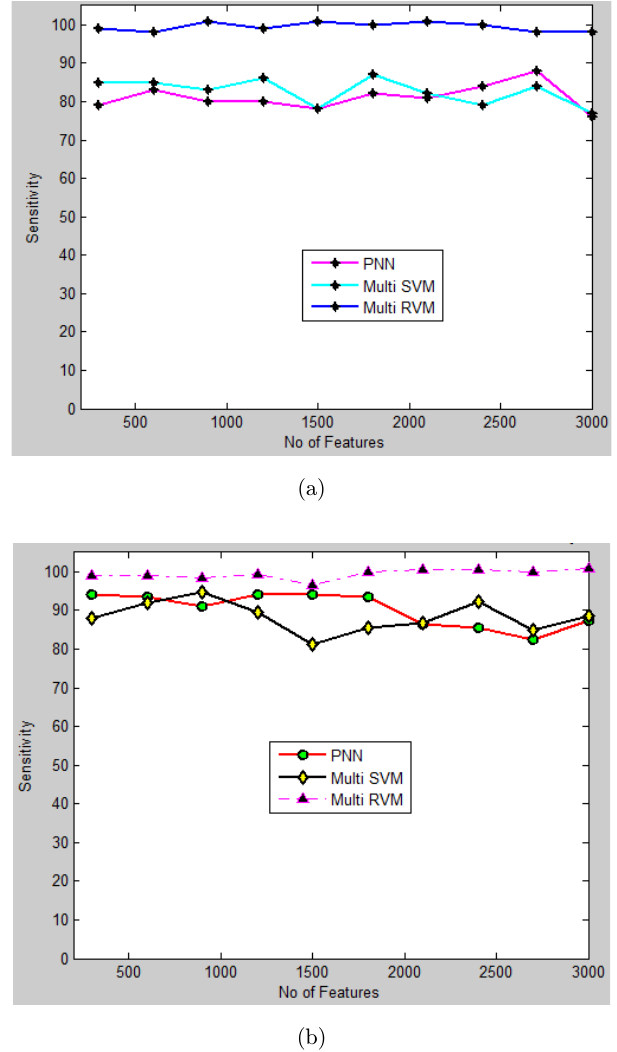
Fig. 15. (a) and (b) Sensitivity result of M-RVM, PNN and Multi-SVM